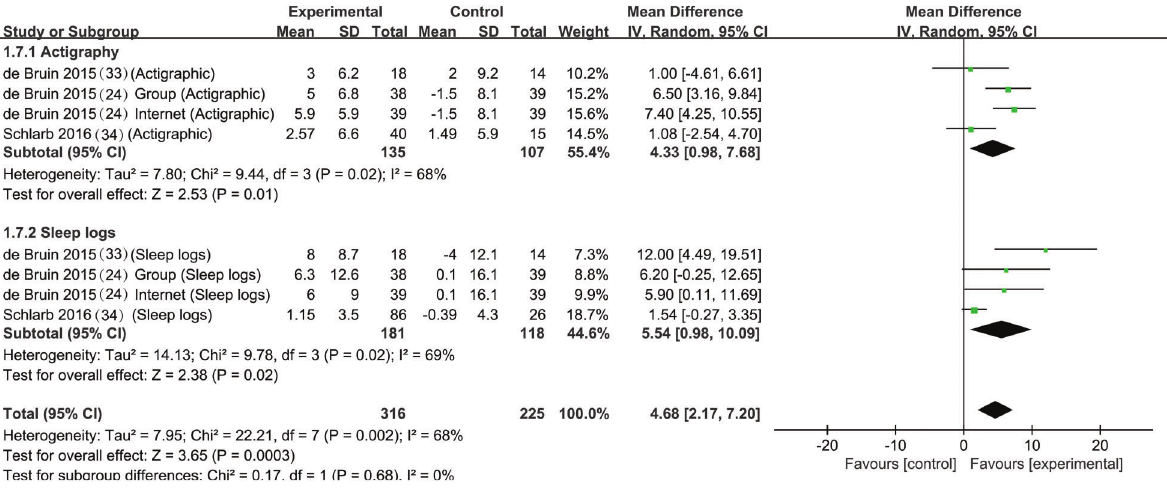
Figure 3. Meta-analysis of the effect of cognitive behavioral therapy for insomnia on sleep ef fi ciency